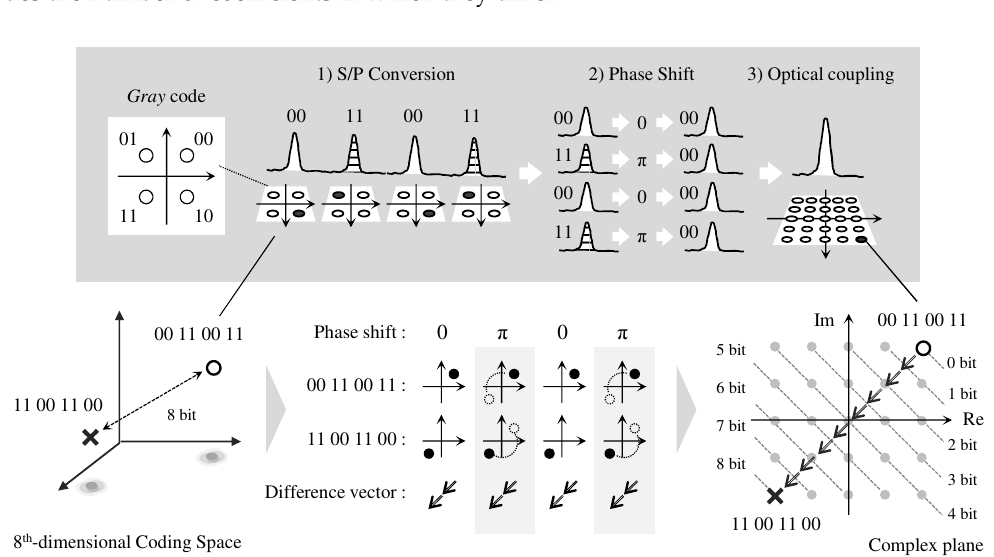
Figure 1. Operating principles of the optical comparator for an 8-bit quadrature phase-shift keying (QPSK) signal. In this figure, the comparator is designed for a “00 11 00 11” code to set their phase shifts at ( 0, π ,0, π ) , and the working example is illustrated when a “11 00 11 00” signal is input. It is shown that the Hamming distance of d H ( 00110011,11001100 ) corresponds to the distance of both